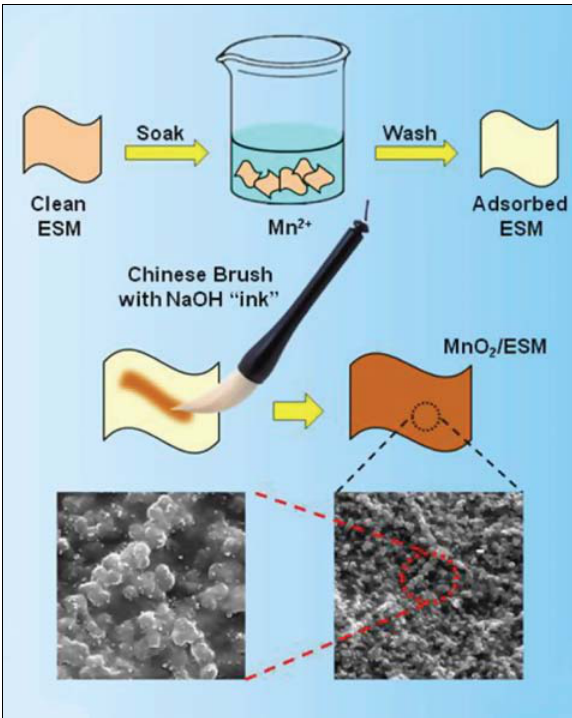
SMPs. Scale bar 2